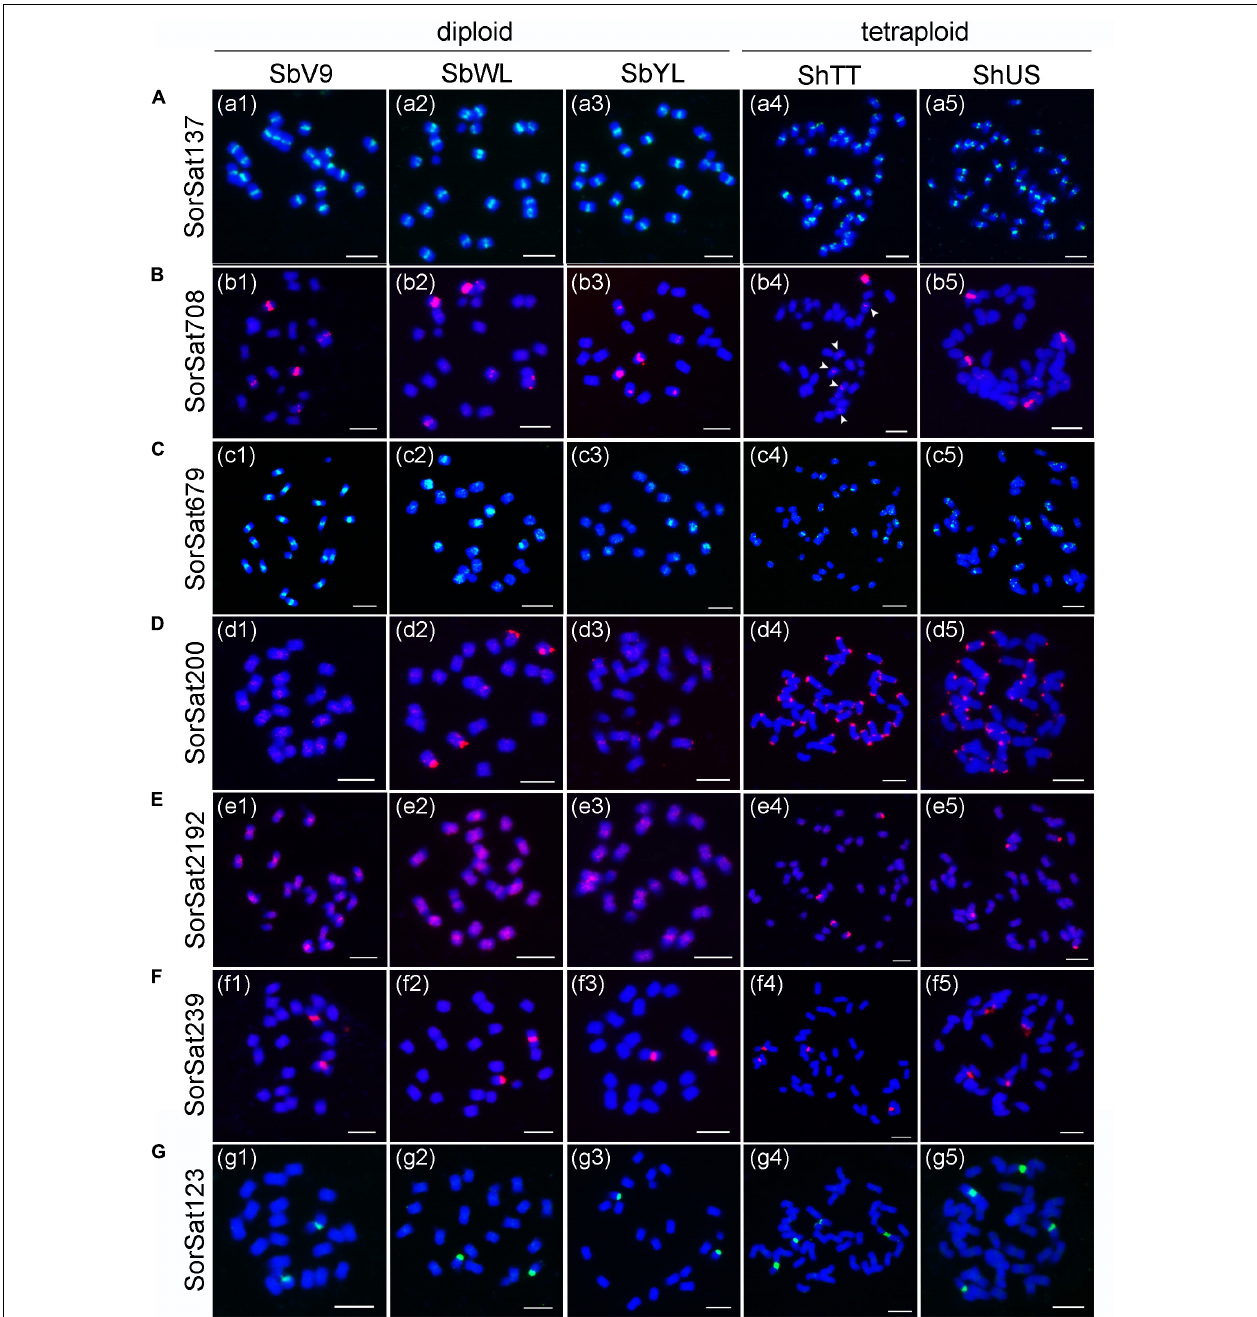
FIGURE 2 | FISH mapping of the seven satellite repeats in the five Sorghum accessions. The satellite repeats include (A) SorSat137, (B) SorSat708, (C) SorSat679, (D) SorSat200, (E) SorSat2192, (F) SorSat239 and (G) SorSat123. Mitotic metaphase chromosomes were counterstained with DAPI. The signals of the satellite probes were pseudocolored in either red or green. The weak signals in (b4) are indicated by arrowheads. The name of Sorghum accession is labeled in abbreviation ( Table 1 ). Bar = 5 µ m. data, CL2 (SorSat137) is the only satellite repeat